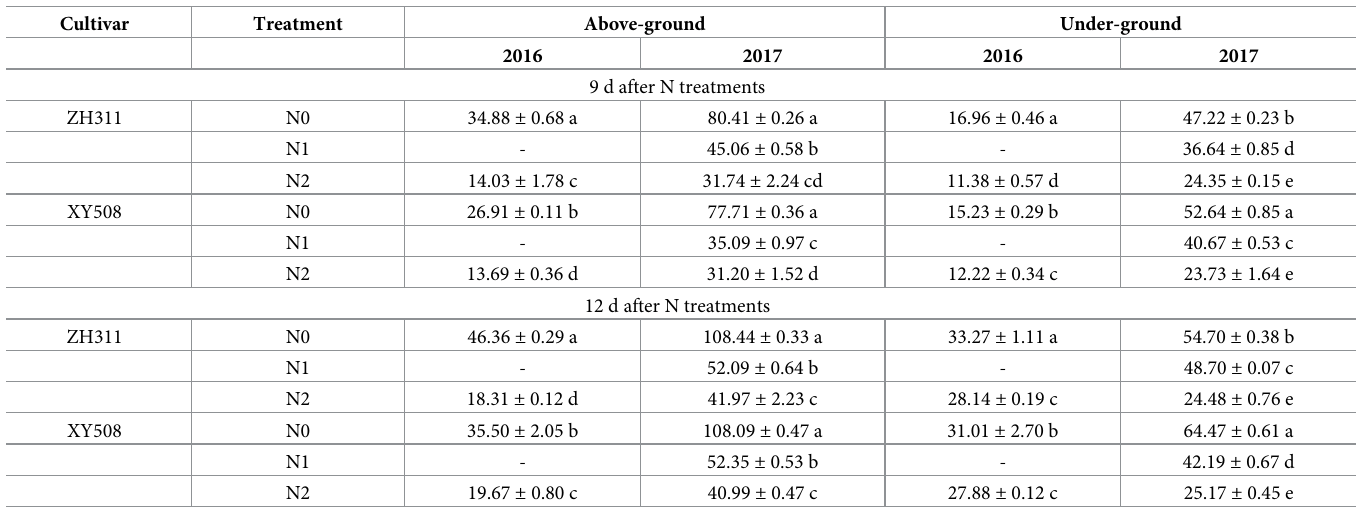
Table 4. NSC in maize at the seedling stage (mg g -1 ). Cultivar Treatment